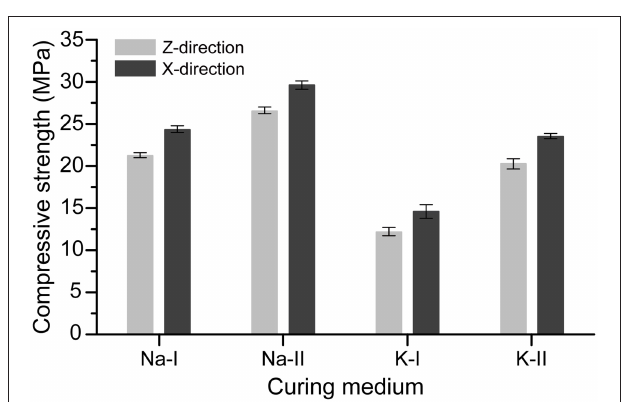
FIGURE 5 | Seven-day compressive strength of the heat cured 3D printed geopolymers. Note: The test result for the Na-II curing medium in the X-direction adopted from Xia and Sanjayan (2018). The error bars are calculated by standard